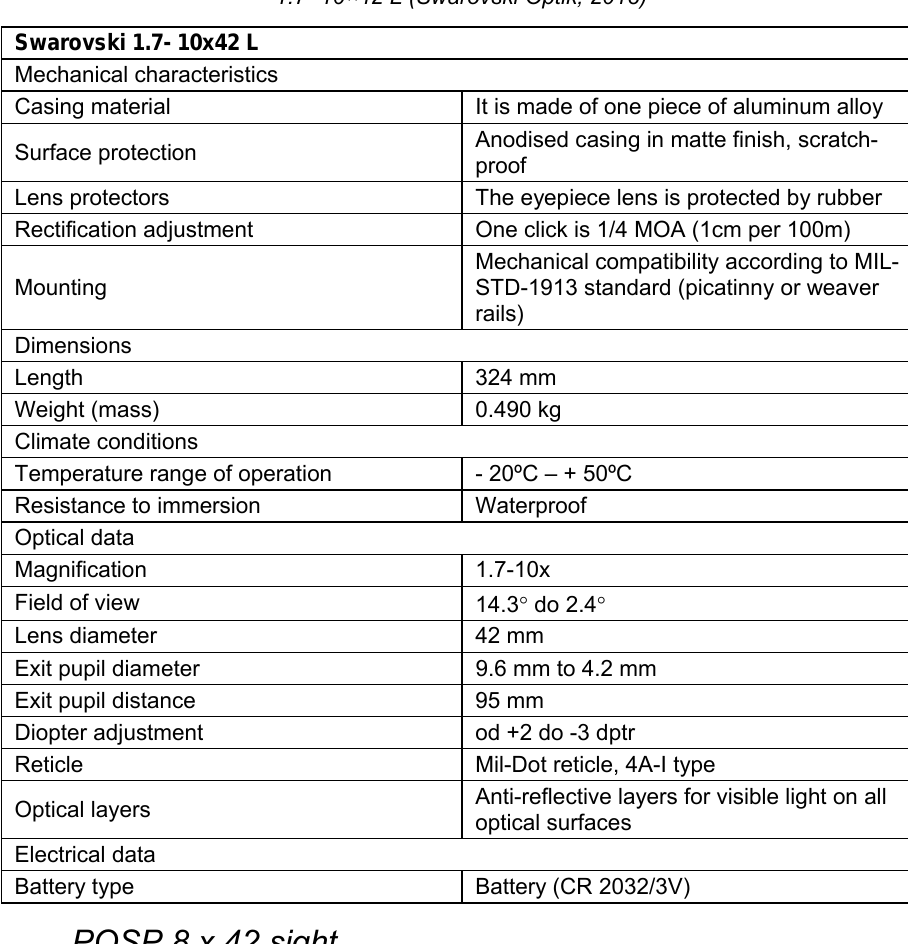
Table 9 – Technical-technological characteristics of the Swarovski 1.7- 10x42 L optical sight (Swarovski Optik, 2018) Таблица 9 – Технико - технологические характеристики оптического прицела Swarovski 1.7- 10x42 L (Swarovski Optik,